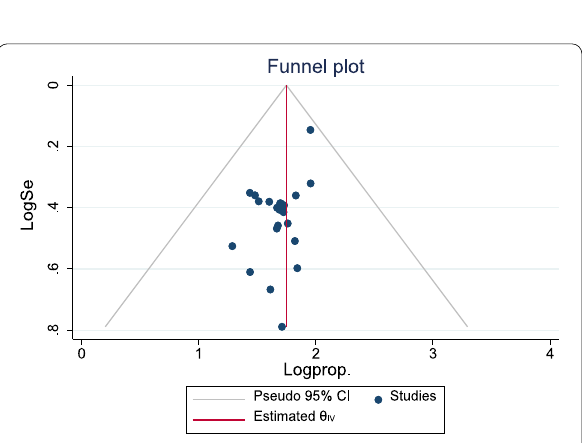
Fig. 4 Funnel plot with 95% confidence limits of the pooled proportion of food hygiene practice among food handlers in